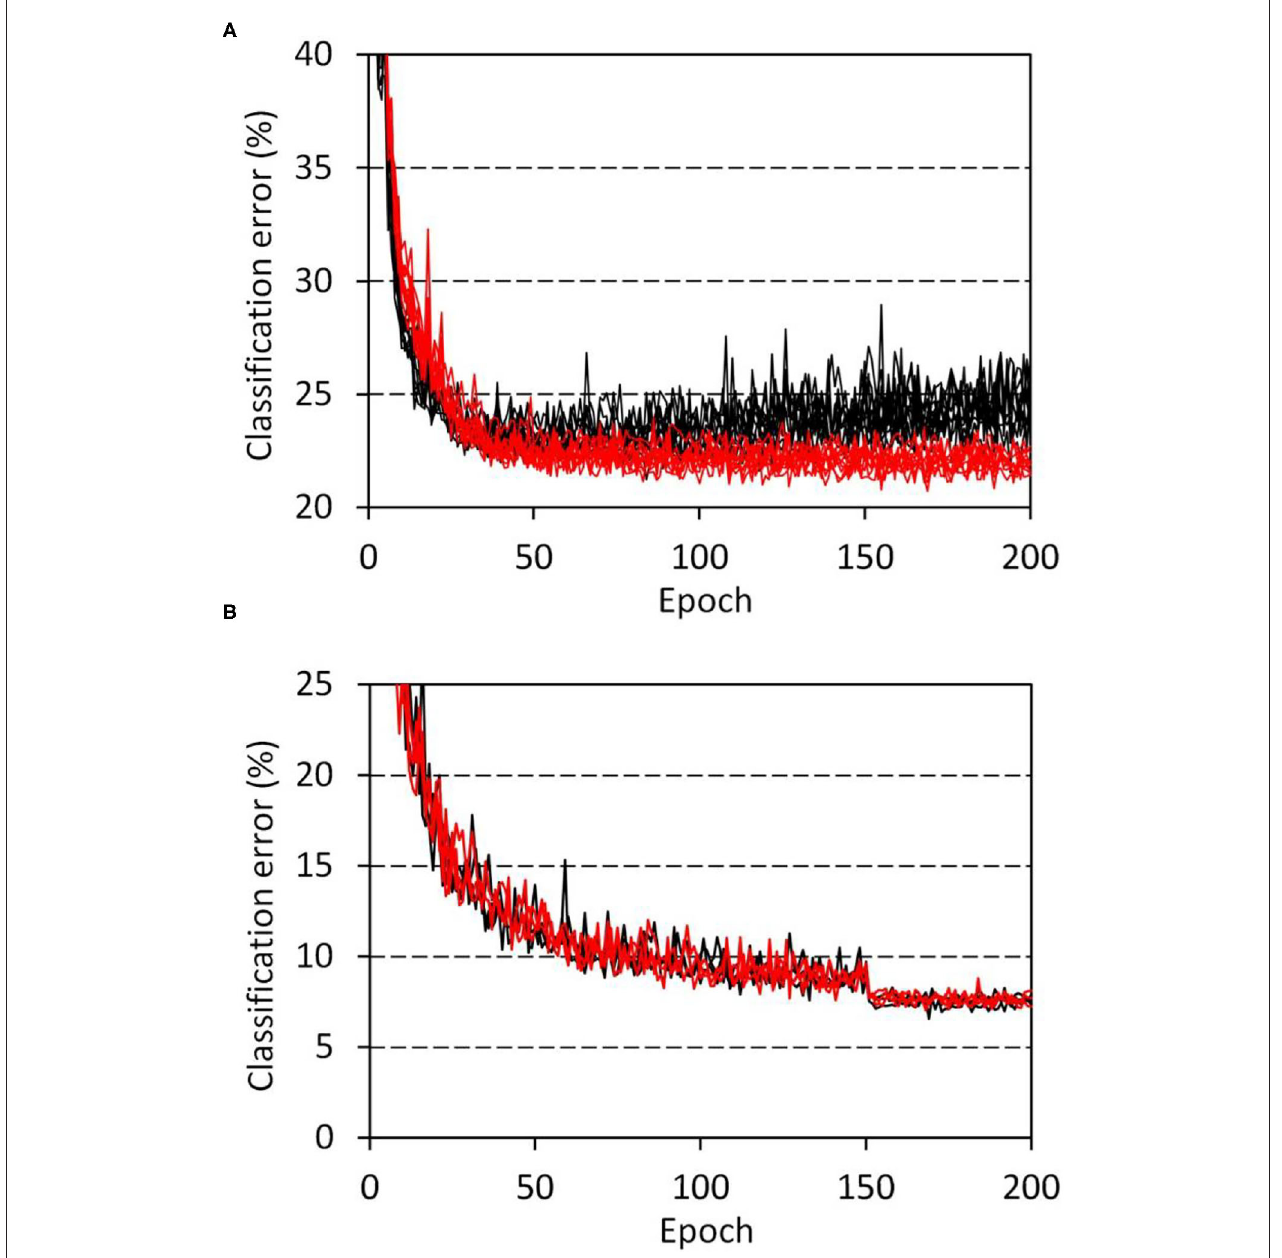
FIGURE 4 | Progress of training in the CIFAR-10 classification tasks. (A) Network C ( Table 1 ) with a schizophrenia connection layer was trained for 10 sessions, and the resultant errors are plotted in red. Parameter reduction in the schizophrenia layer was set to 50%. Errors of the control network with the same configuration but having a fully connected layer are plotted in black. (B) VGG network E ( Table 1 ) with schizophrenia convolution layers was trained for 3 sessions, and the resultant errors are plotted. Results for the schizophrenia network with a 60% parameter reduction in the last three convolution layers are drawn in red, while those of a control network without the parameter reduction are drawn in